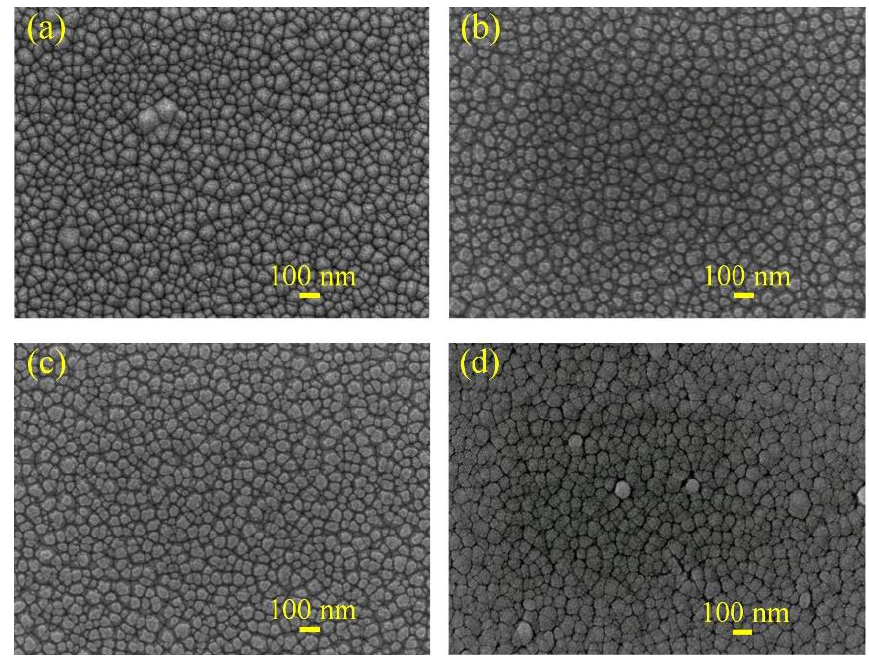
Figure 4. The surface morphologies of as-deposited ( a ) and RTA treated (( b ) 300 °C, ( c ) 400 °C and ( d ) 500 °C) ZnO thin films for 10 min.